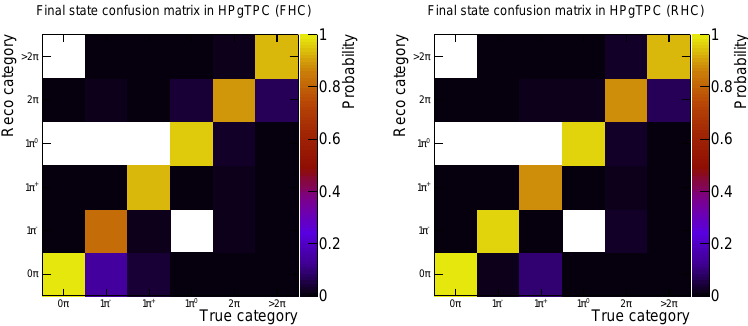
Figure 67. Confusion matrices for various pion multiplicities within the HPgTPC for both forward and reverse horn